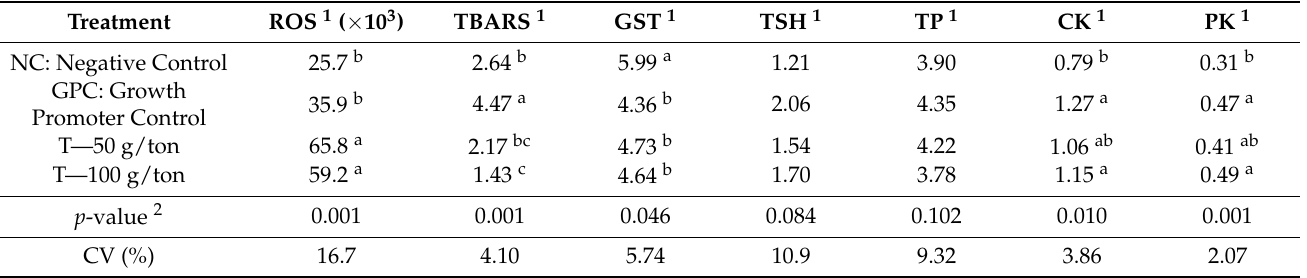
Table 6. Oxidant/antioxidant and energetic metabolism enzyme status in the homogenate of the jejunum of broilers fed an antimicrobial blend to replace growth promoters.